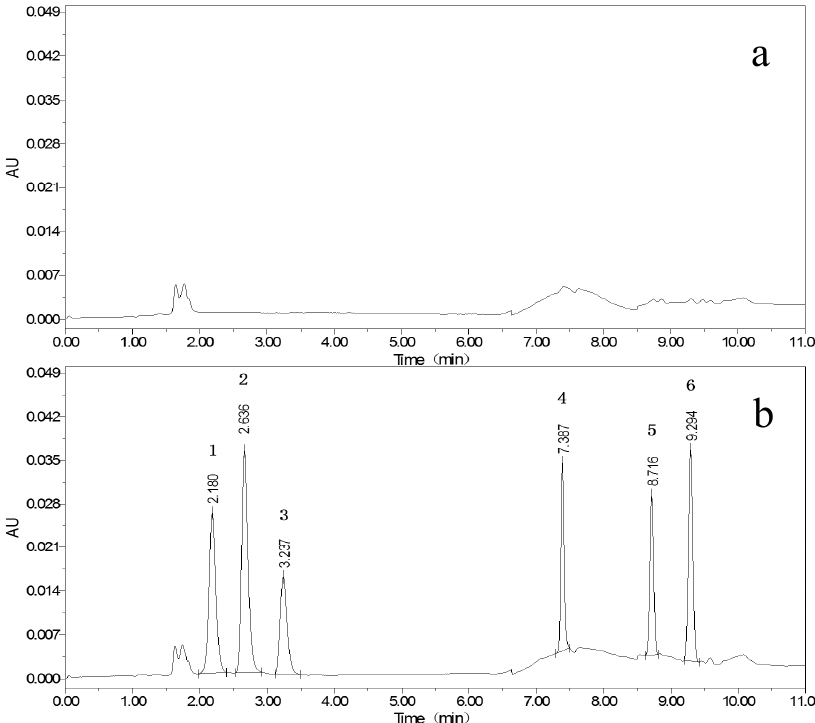
Figure 2. Chromatograms of blank egg yolk ( a ); and blank egg yolk with 100 µg/kg mixed standards ( b ) (ABZSO 2 NH 2 (1), ABZSO (2), ABZSO 2 (3), ABZ (4), AVM (5), IVM (6)). Foods 2022 , 11 , x FOR PEER REVIEW